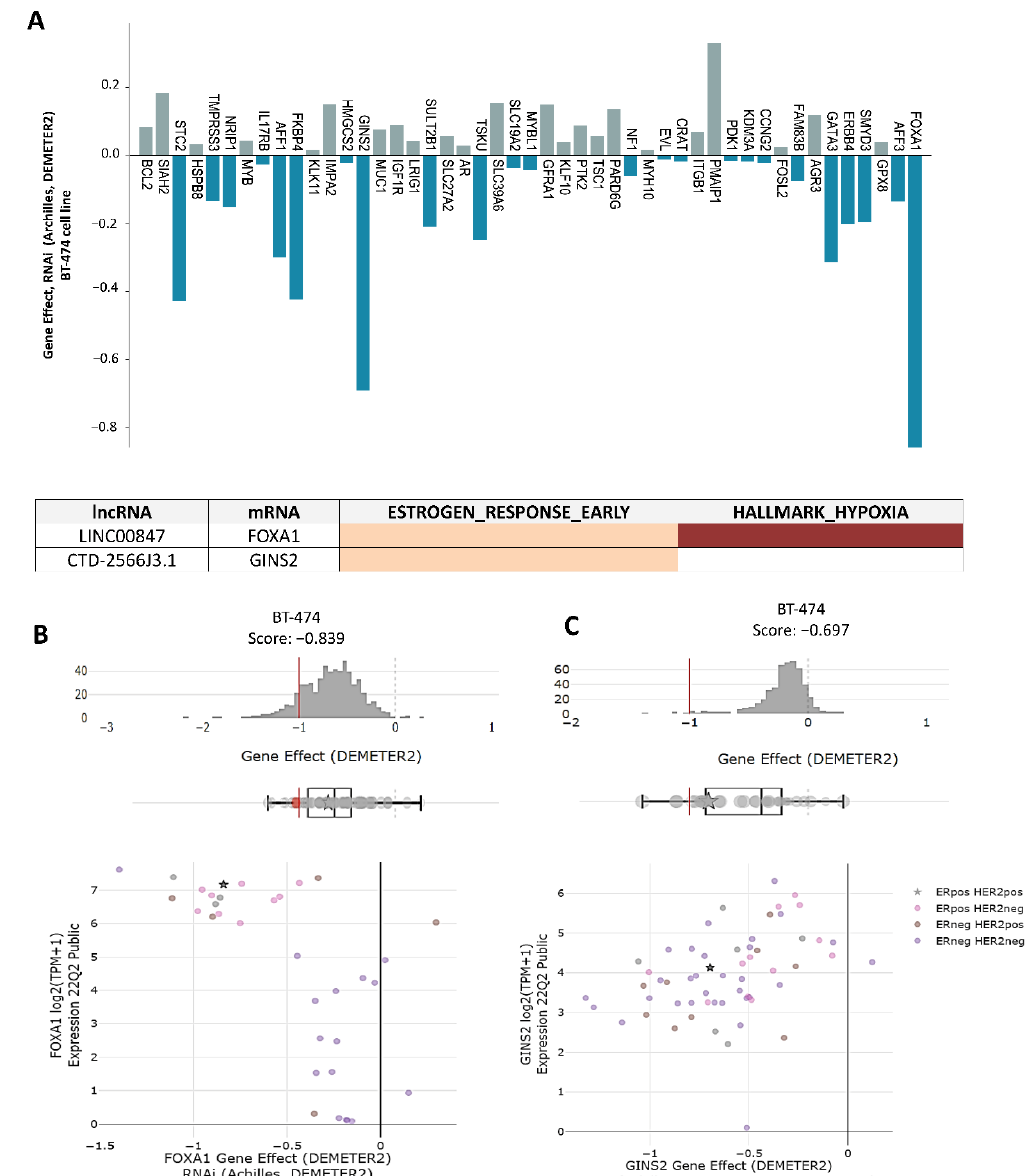
Figure 7. LINC00847-FOXA1 and CTD-2566J3.1 GINS2 are essential genes for proliferation and survival. ( A ) DEMETER score values for each mRNA reported in the co-expressed mRNAs/lncRNAs pairs of 3D cultures and TCGA data. ( B , C ) The DEMETER score is shown against the gene expression of FOXA1 and GINS2 ; the stars represent BT-474 cell line and the color dots represent the breast cancer subtype of each cell line.